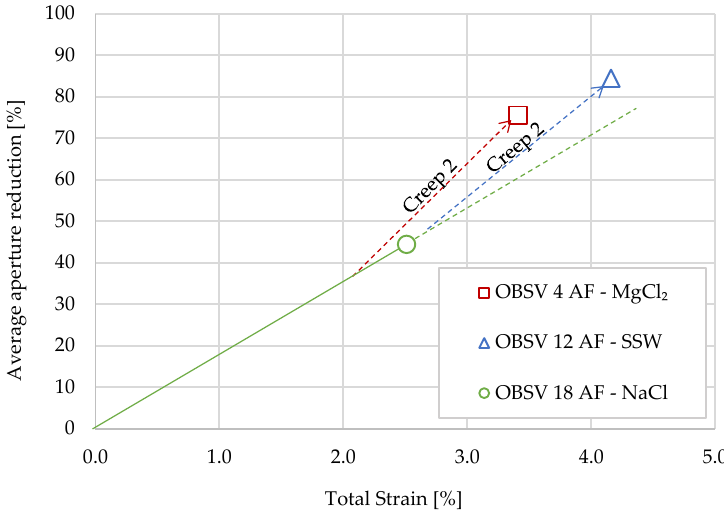
Figure 12. The graph presents the link between the average aperture reduction [%] and the total axial strain [%] experienced during Loading, Creep 1, and Creep 2 for the three artificially fractured cores (radial strain was not identified in this hydrostatic test; however, the aperture reduction is necessarily a result of the combined strain). A linear relationship between total strain [%] and aperture reduction [%] for OBSV 18 AF-NaCl is marked from origo through the final point of axial strain and aperture reduction (the reduction is expected to be related to mechanical forces only). The deviation above the linear relationship for OBSV 4 AF-MgCl 2 and OBSV 12 AF-SSW are ambiguous estimations related to aperture reduction caused by mineral precipitation during Creep